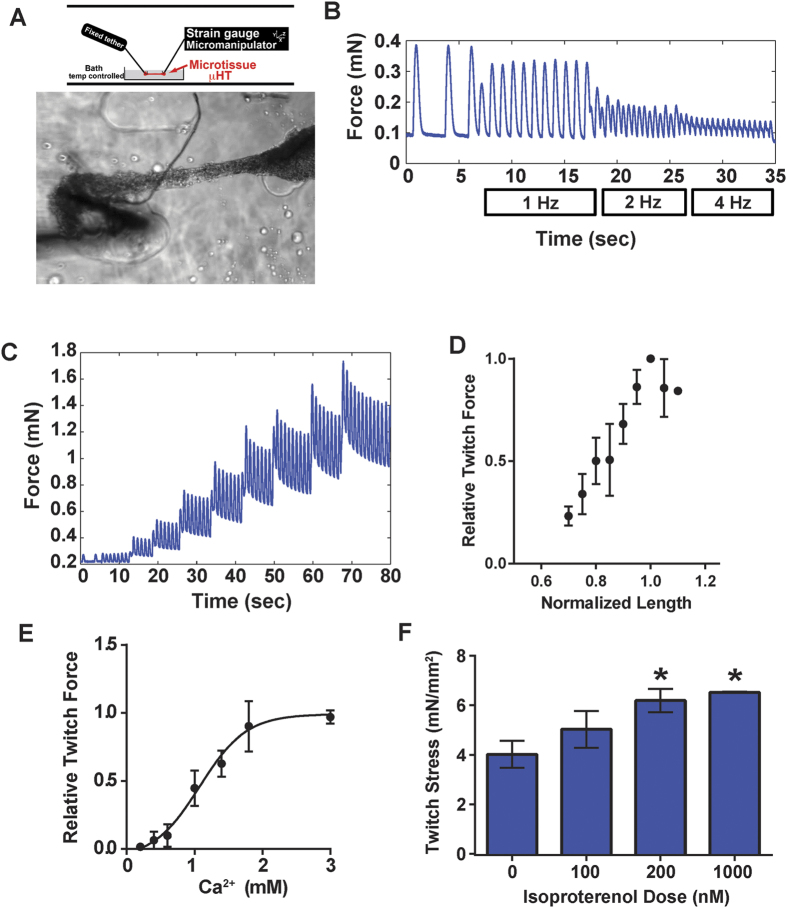
Organ Bath Physiology of Micro-Heart Muscles after Removal from Array Format.(A) Schematic (top) and representative image (bottom) of a μHM mounted onto hooks attached to a tether on one end and a strain gauge and micro-manipulator on the other end. (B) Force over time of a mounted 2 week μHM (0.1 mN baseline force) either beating spontaneously, or subjected to field pacing at 1–4 Hz. (C) Representative Frank-Starling analysis of a μHM. Tissue was stretched by 50 μM at regular intervals, and the resultant baseline and twitch force were recorded, demonstrating an increase in twitch force. (D) Quantification of the Frank-Starling response in mounted μHM. Tissue length was defined as 1 at the length that yielded maximum twitch-force, which plateaued thereafter. (E) Quantification of calcium dose response (increasing twitch force) in μHM (EC50: 1 mM). (F) Twitch force of μHM within five minutes of treatment with increasing doses of isoproterenol. Error bars: SD, n = 3 (pooled from two independent batches of iPS-CM and EB-stromal cells). Note for normalized tissue length of 1.1, n = 1.